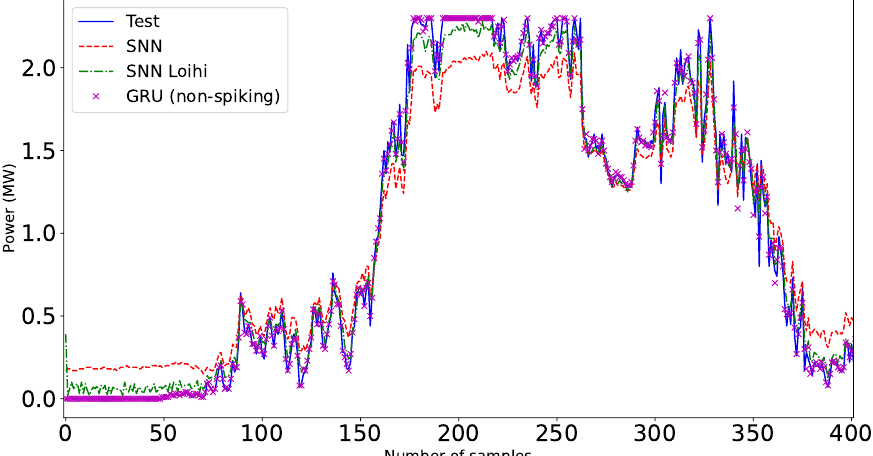
Figure 15. One-step ahead WPFs with the SNN architecture (dashed red line), running the SNN on the Loihi emulator (dash-dot green line) and a non-spiking VMD-GRU model (purple crosses) over the testing